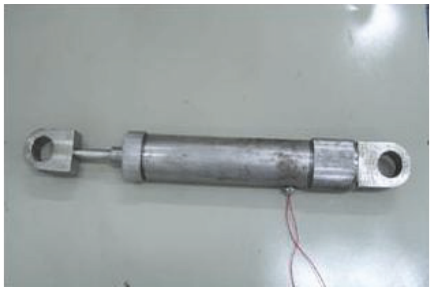
Figure 1: Picture of the MR damper.